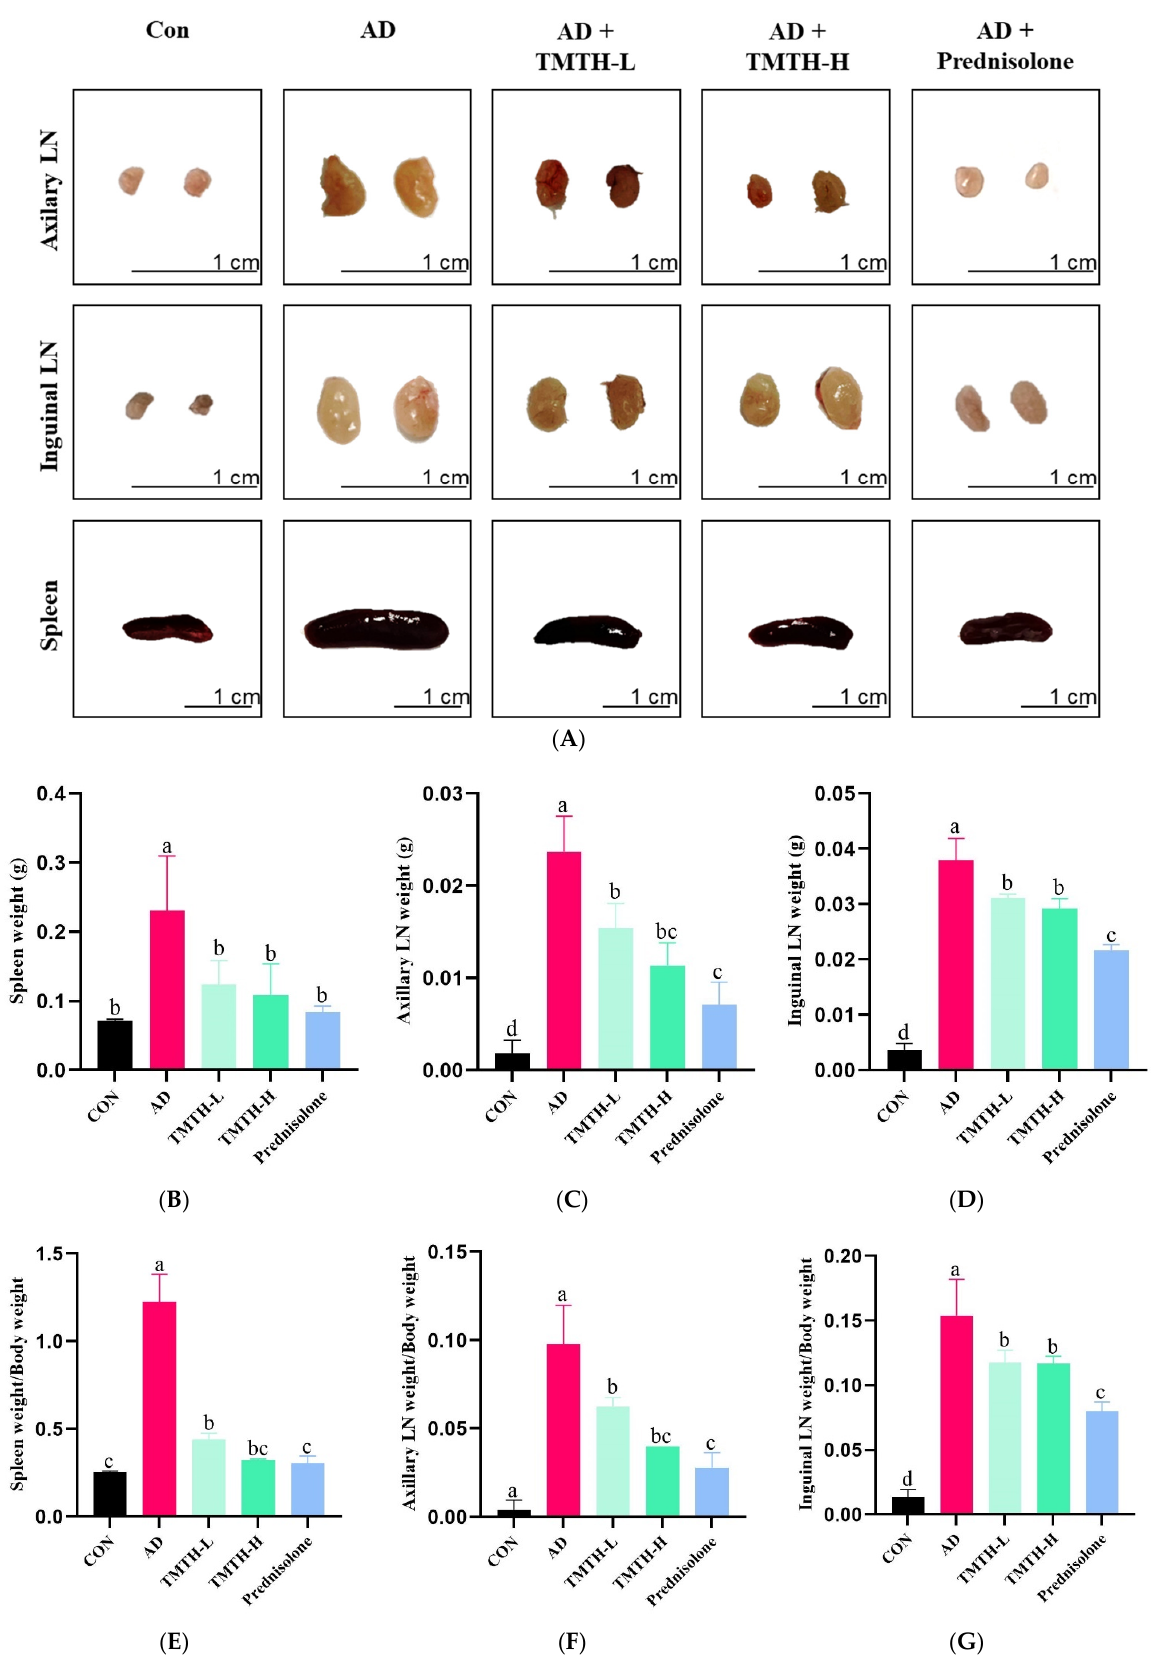
Figure 4. Effects of Tenebrio molitor trypsin hydrolysate (TMTH) on immune organs of 1-chloro-2,4- dinitrobenzene (DNCB)-induced mice. ( A ) Photographs of axillary lymph nodes (LNs), inguinal